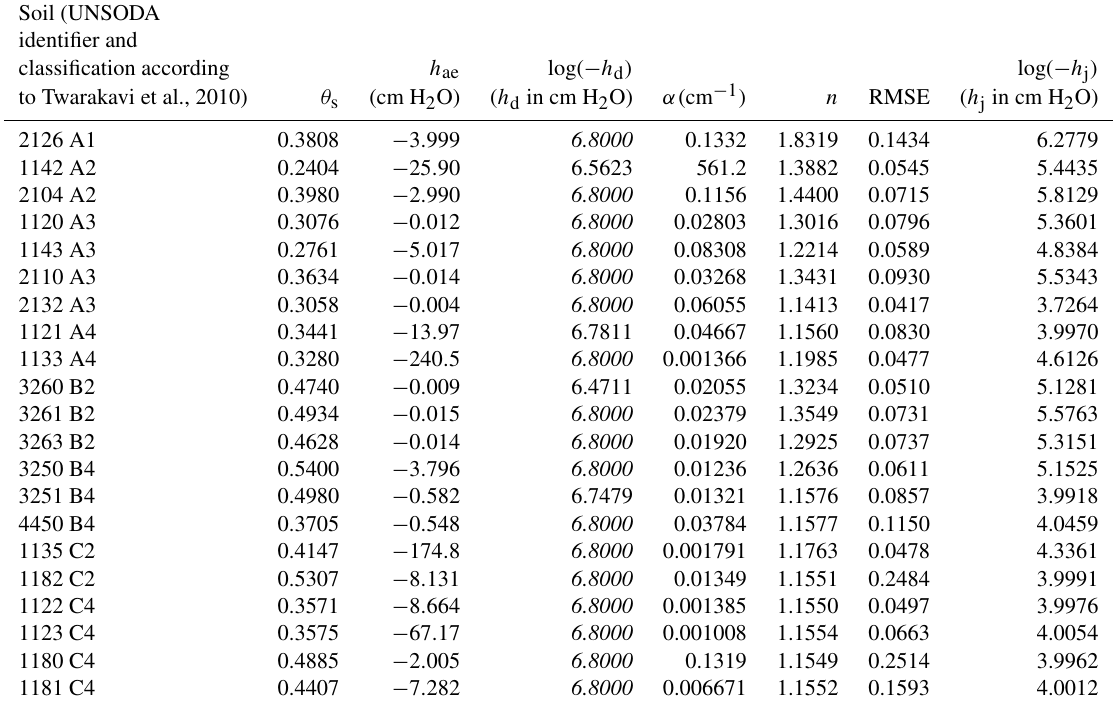
Table 1. Fitted parameter values and the root mean square error (RMSE) of the best fits for 21 soils. The corresponding values of the derived parameter h j are given as well. If parameter h d was fixed during the fitting operation, its value is denoted in italic